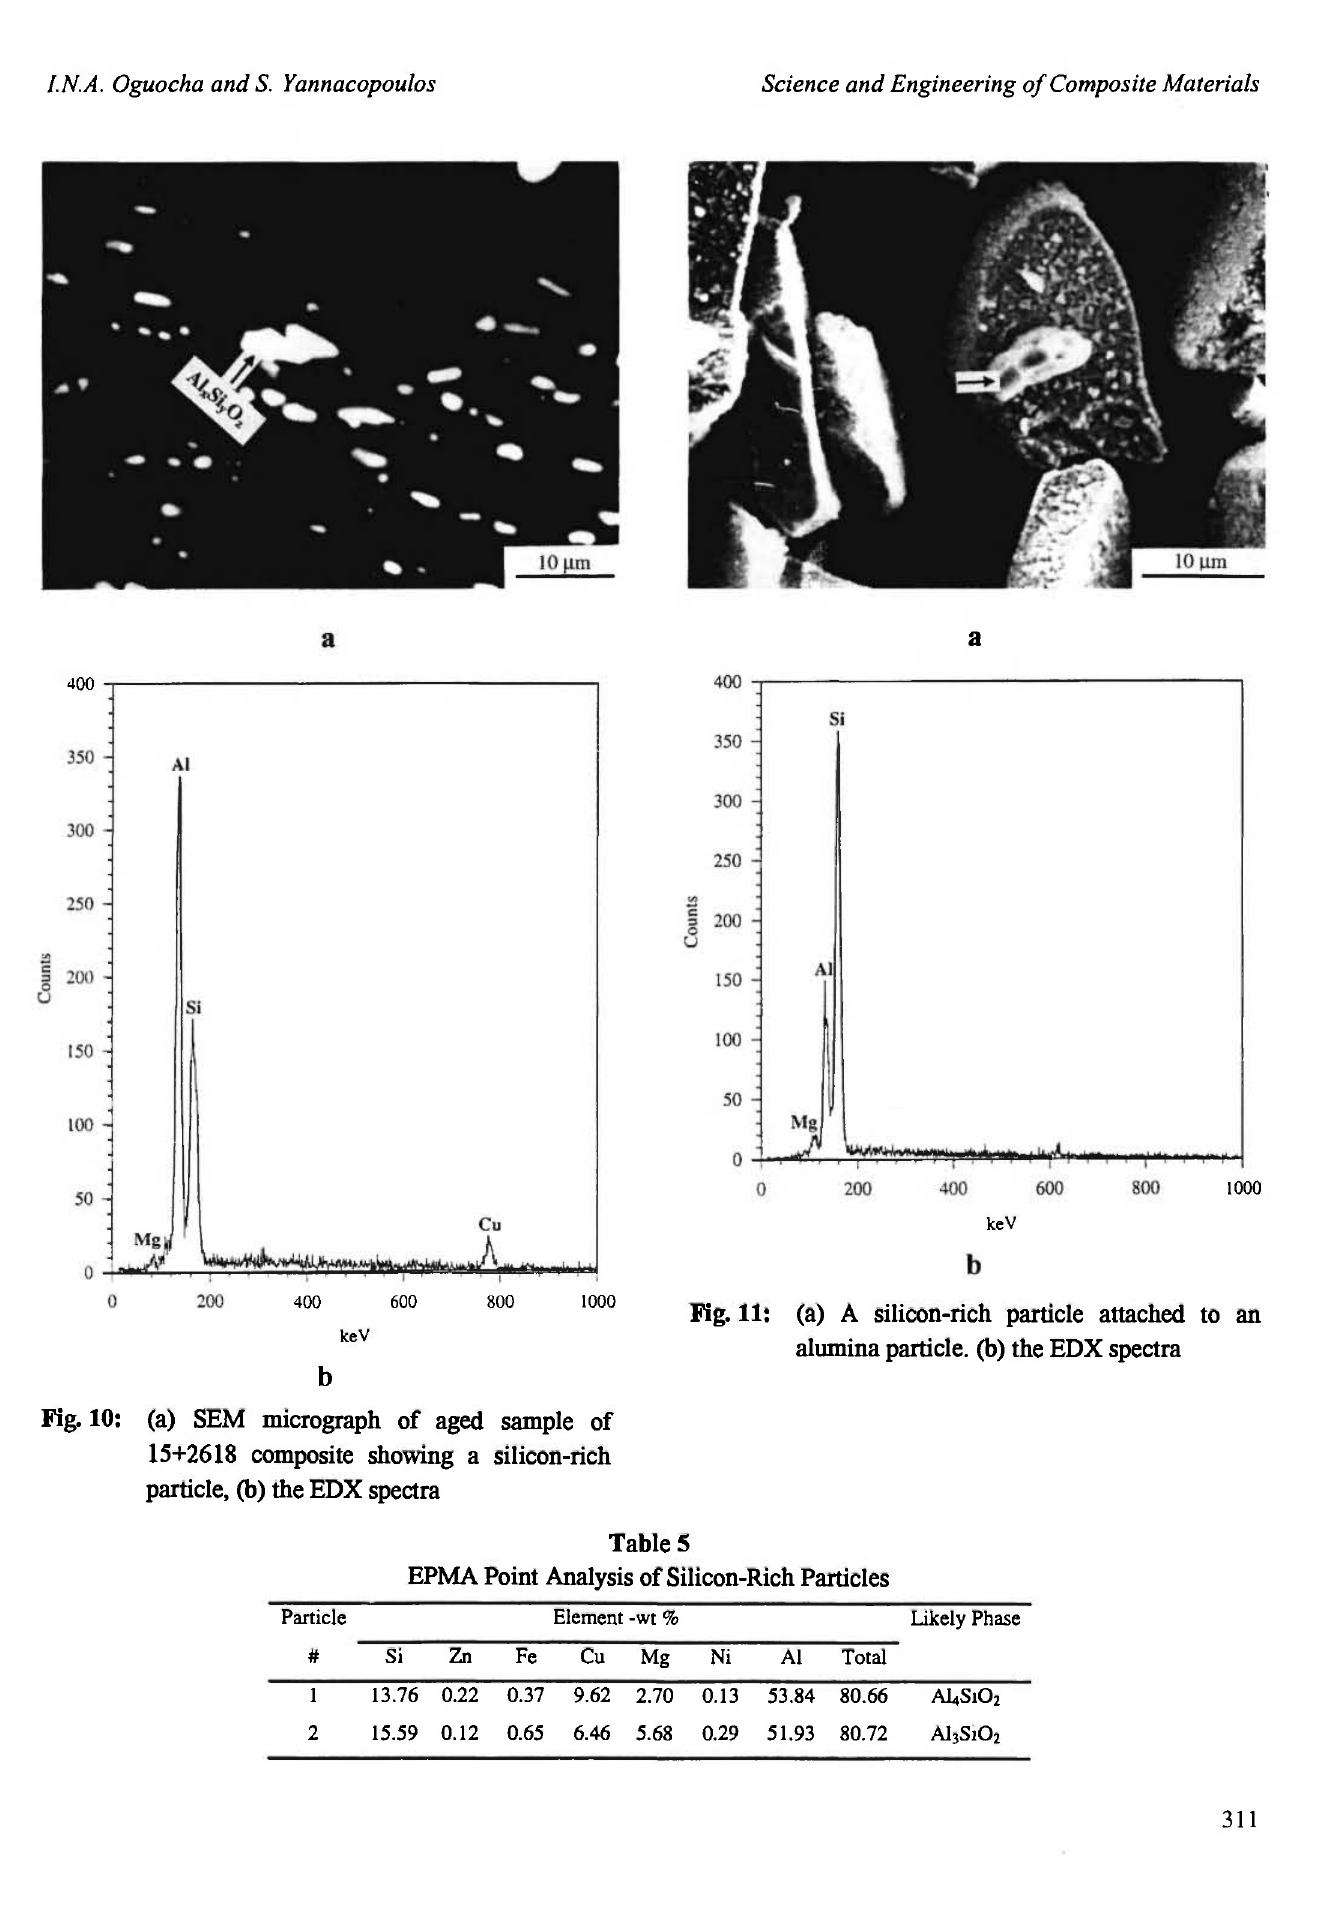
Fig. 11: (a) A silicon-rich particle attached to an alumina particle, (b) the EDX spectra Fig. 10: (a) SEM micrograph of aged sample of 15+2618 composite showing a silicon-rich particle, (b) the EDX spectra ΕΡΜΑ Point Analysis of Silicon-Rich